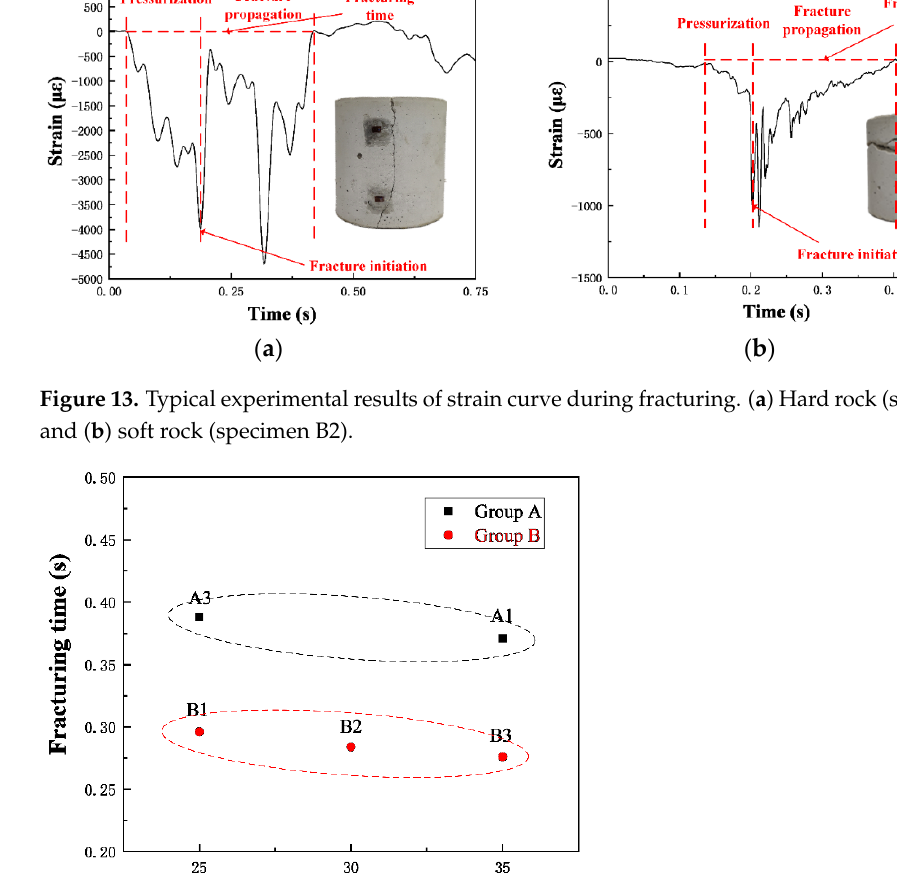
Figure 14. The fracturing times of specimens in group A and B.